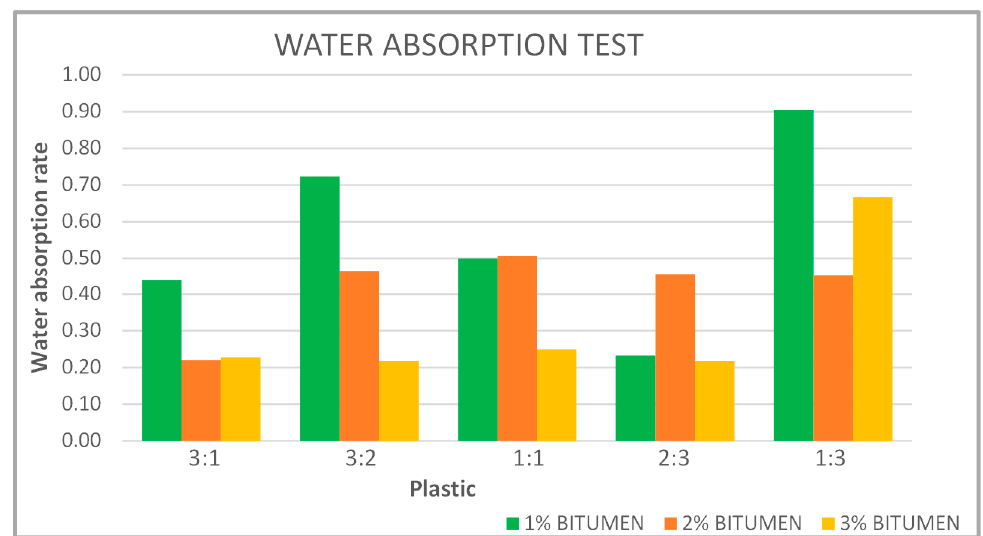
Figure 9. Water absorption rate on different composition of plastic bricks.